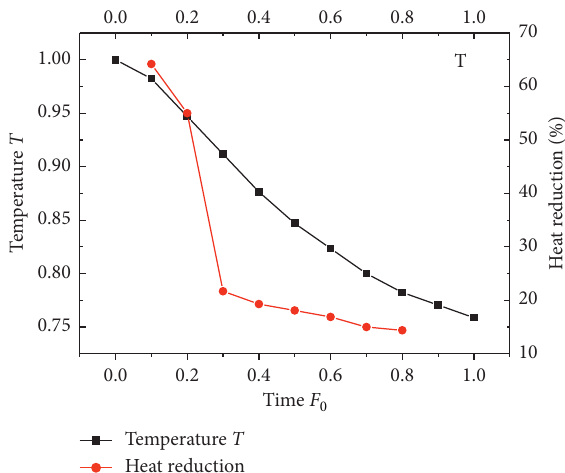
Figure 11: Relationship between the temperature drop at 2 R and the heat reduction of the surrounding rock under Scheme